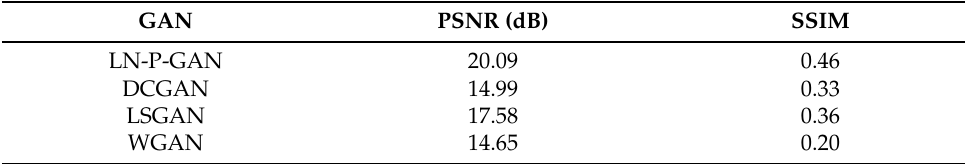
Figure 14. Output image of the contrastive GANs. Table 9. Comparison of the generated